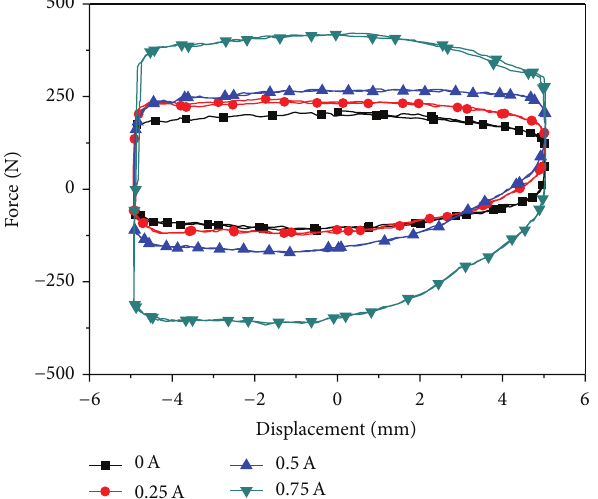
Figure 16: Diagram of experiment force-displacement under differ- ent direct current